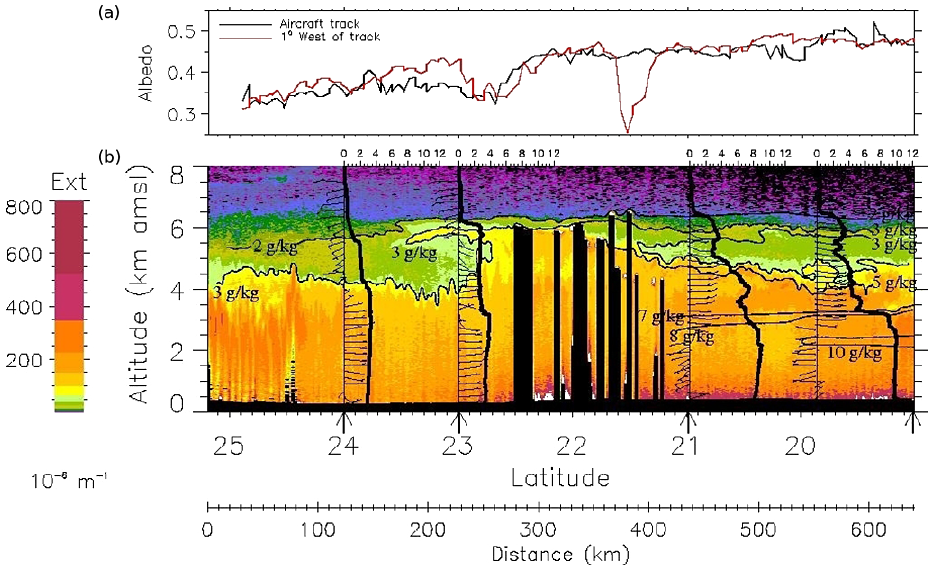
Figure 18. LNG lidar-derived extinction coefficient at 532nm on 20 June 2011 during flight F21 from 25.0 ◦ N, 11.5 ◦ W to 19.0 ◦ N, 8.7 ◦ W. Water vapour mixing ratio (WVMR, gkg − 1 ) and wind profiles from four dropsondes are superimposed (black lines, dropsonde locations indicated by arrows), with WVMR contours drawn by hand using the lidar backscatter; away from the dropsondes these are by necessity subjective and the 7 and 8gkg − 1 contours have not been continued west of 21.2 ◦ N due to a lack of data. Along-track albedo derived from MODIS satellite data and albedo 1 ◦ W of the flight track are shown in the upper